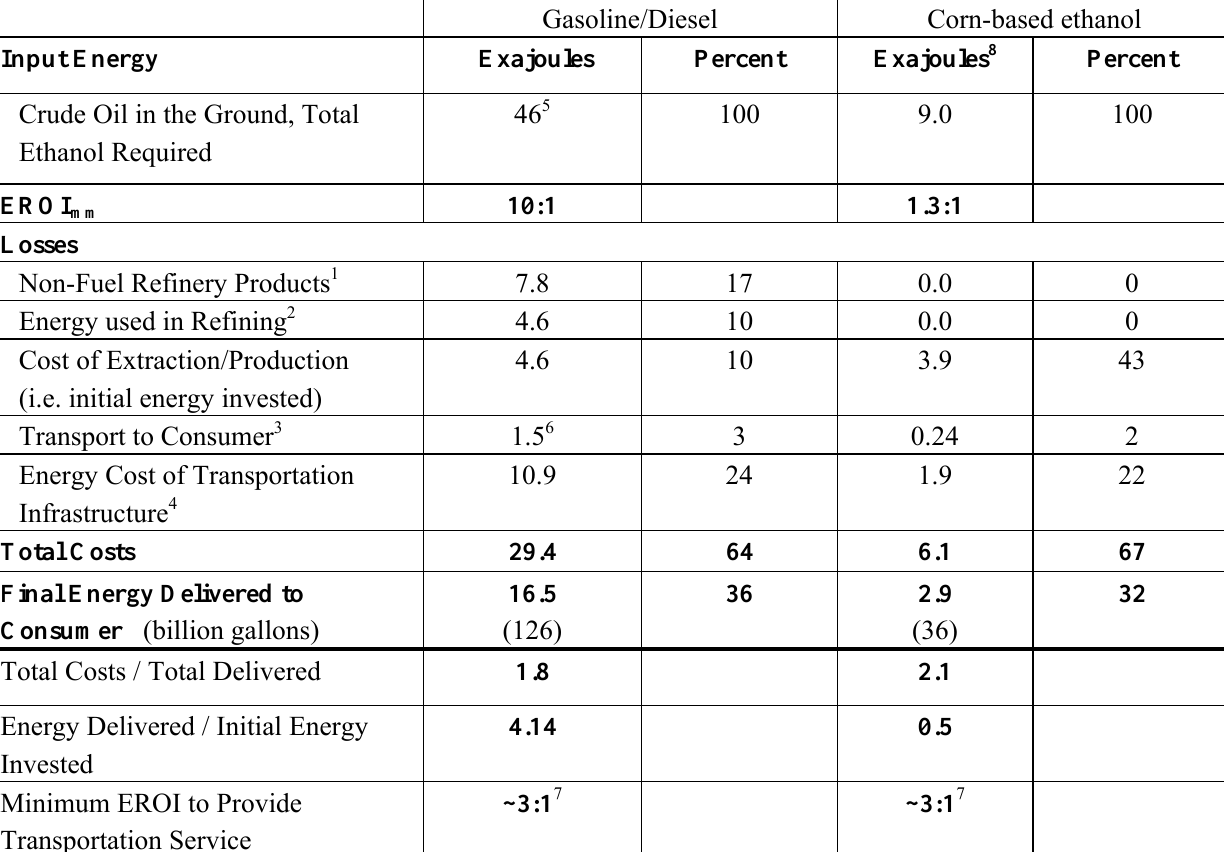
Table 3 . Approximate values and percentages of costs (or losses) in delivering gasoline/diesel and corn-based ethanol to the